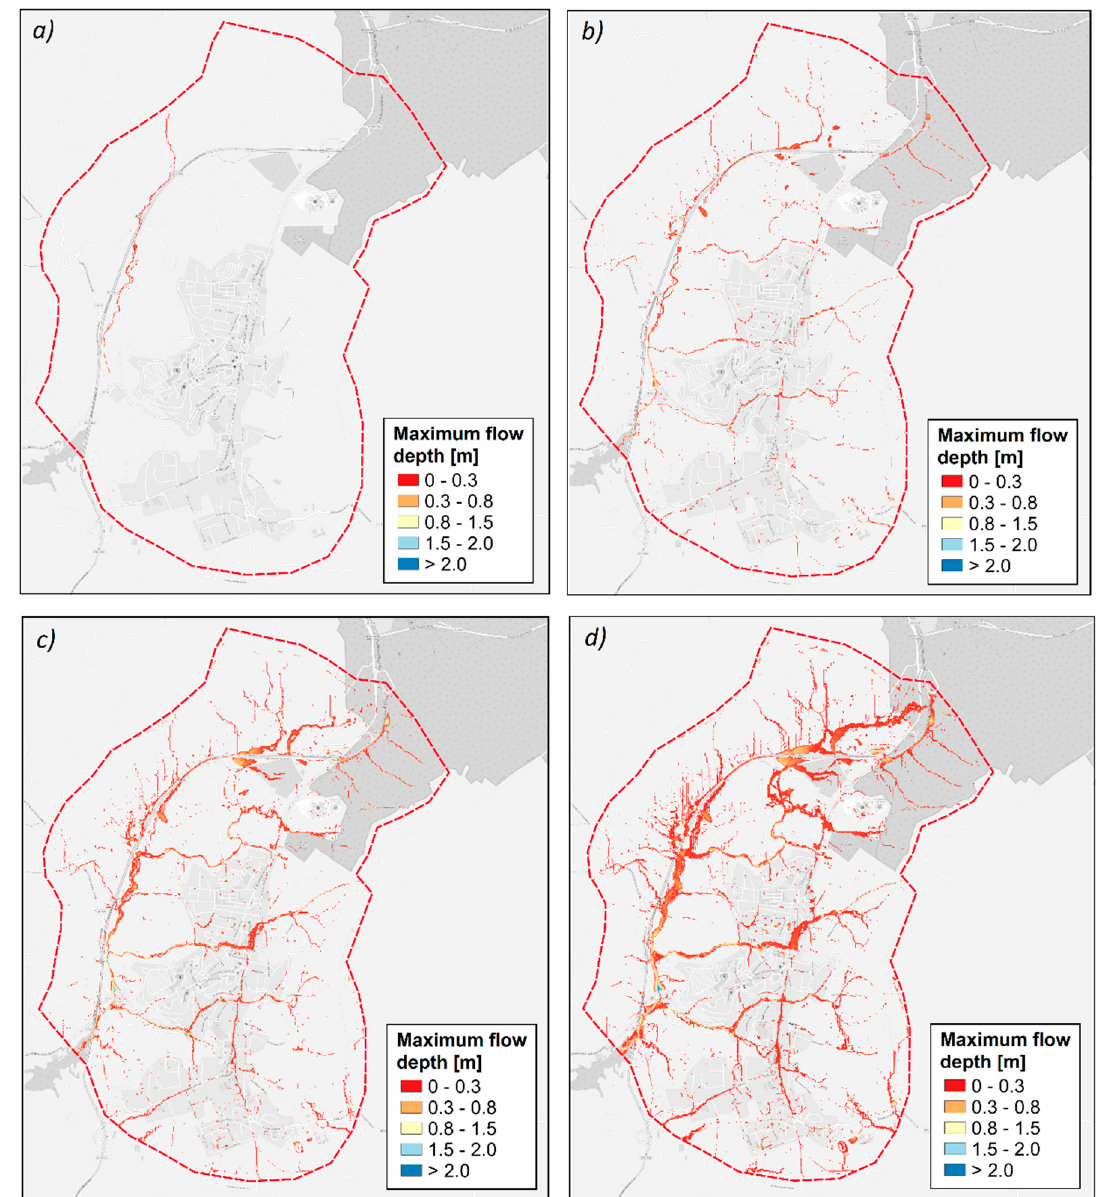
Figure 6. Maximum flow depth for the 2050 scenario: ( a ) T = 2 years; ( b ) T = 5 years; ( c ) T = 10 years; and ( d ) T = 20 years.